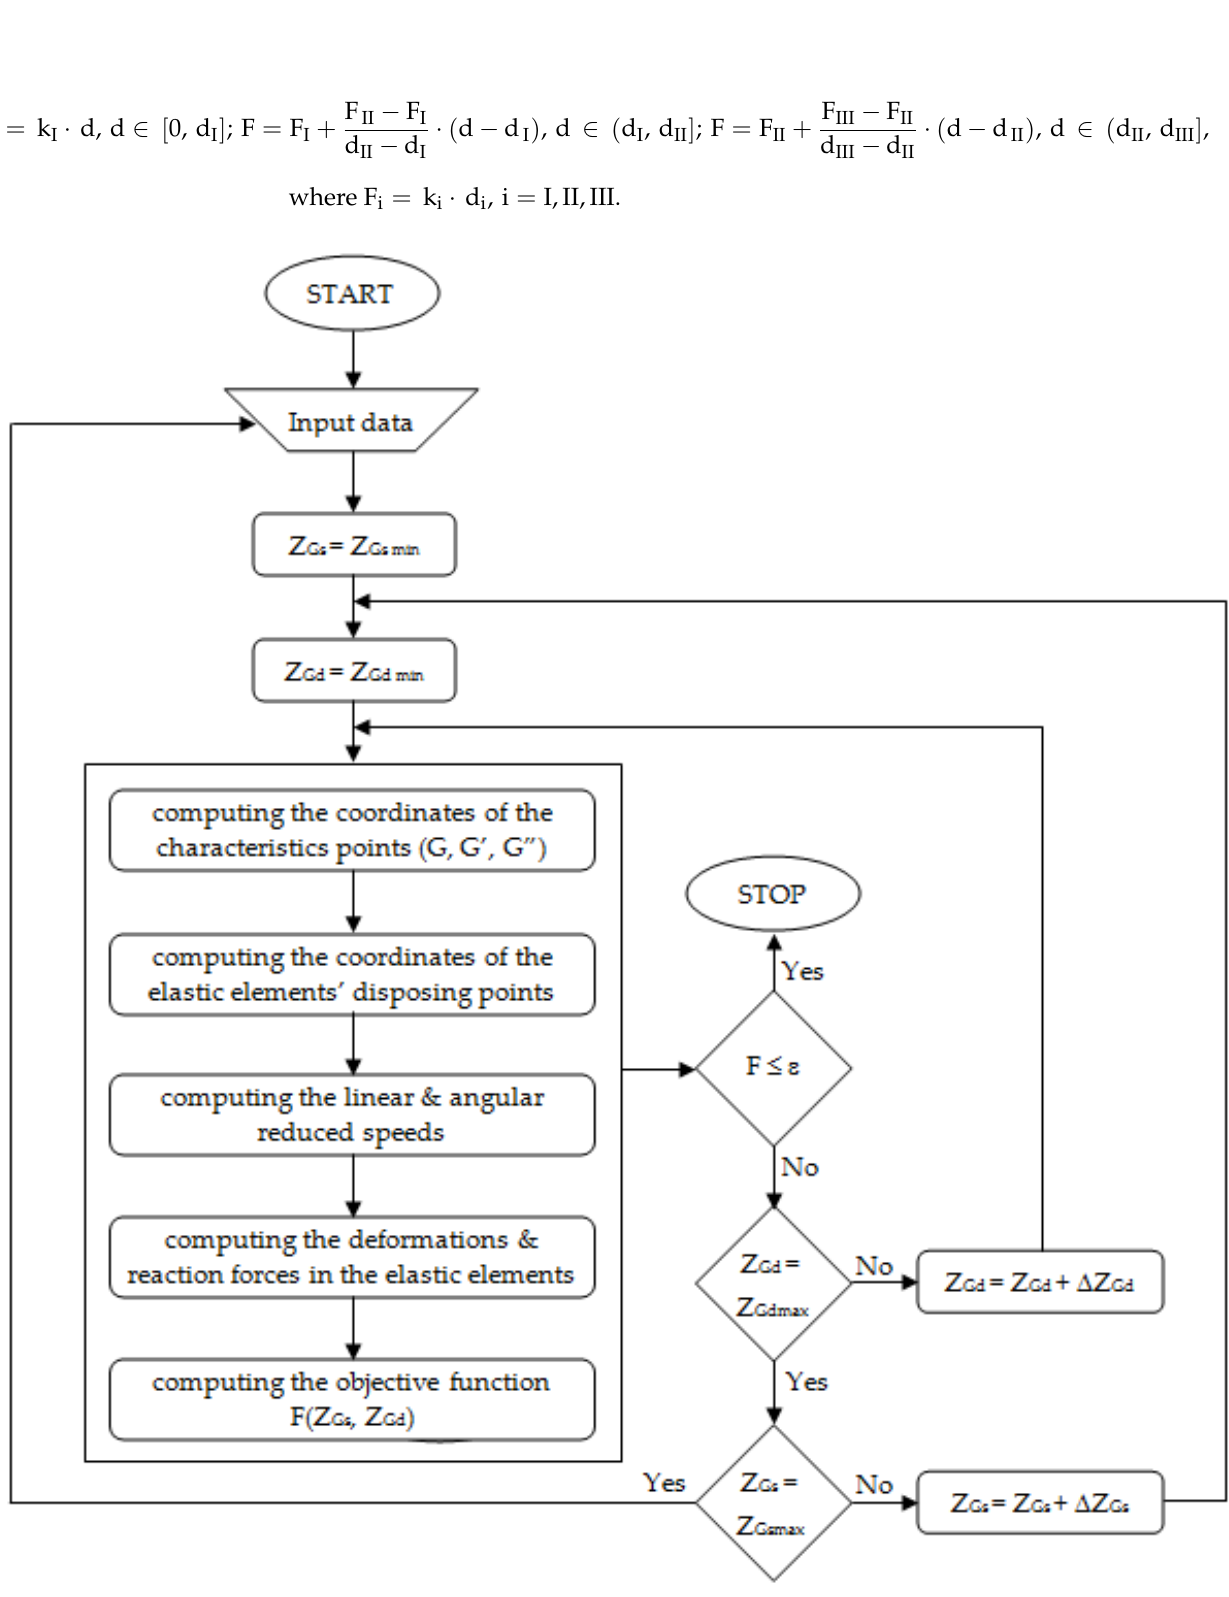
Figure 6. The logical scheme for determining the equilibrium position of the suspension system.